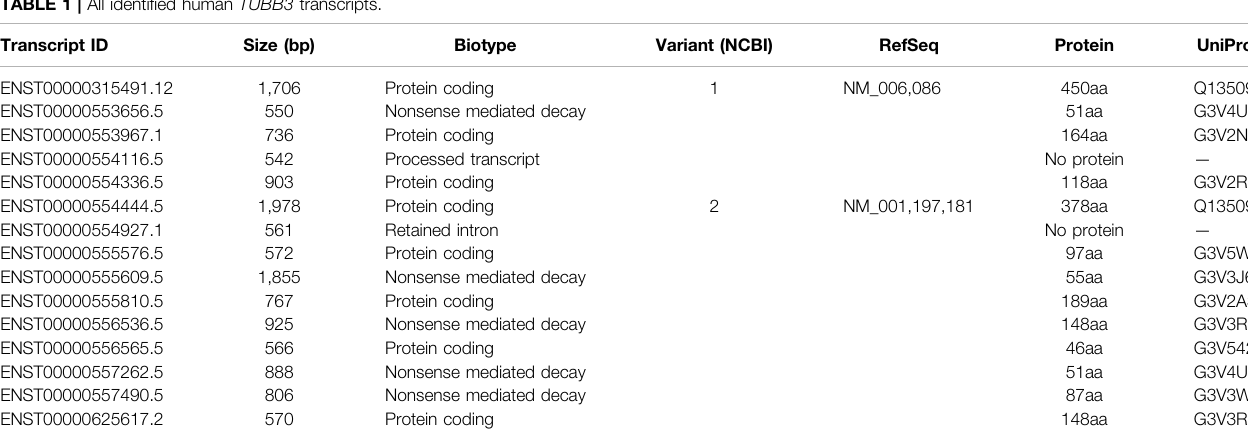
TABLE 1 | All identi fi ed human TUBB3